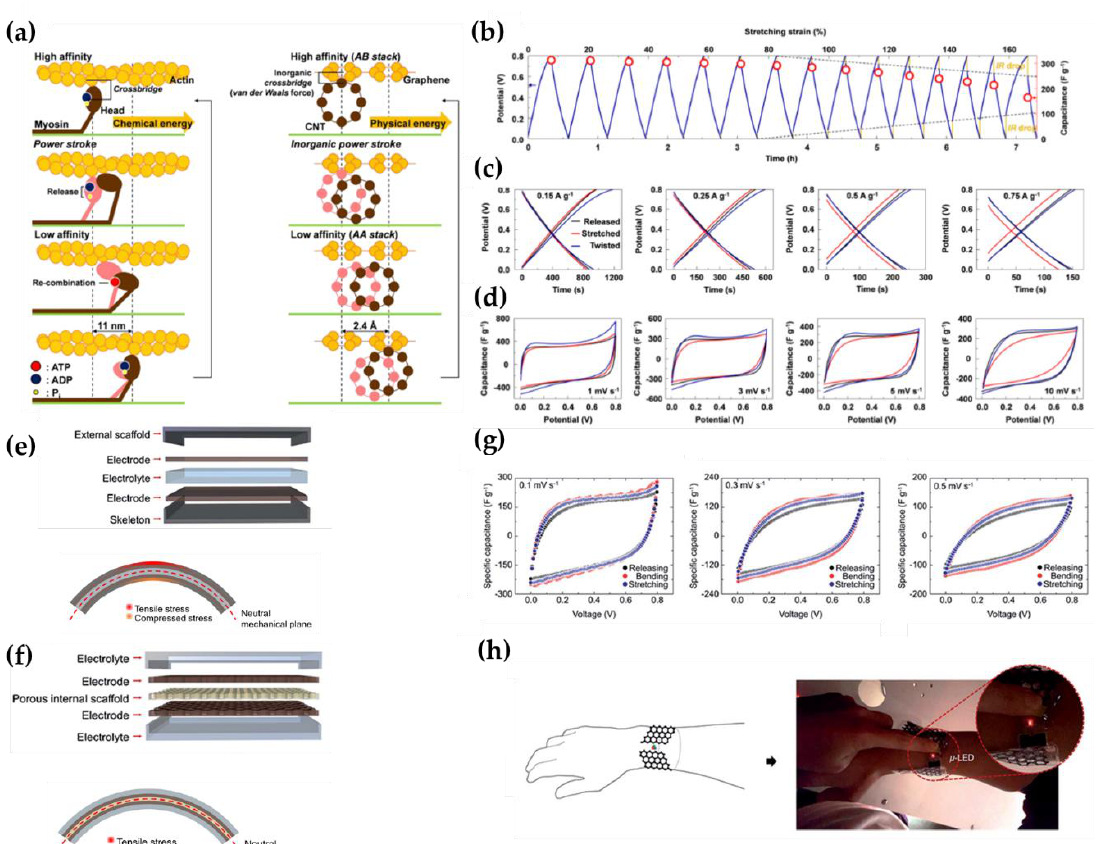
Figure 5. ( a ) Paradigms for the gradual motion of carbon nanotubes (CNTs) along with graphene in an inorganic system and of myosin along actin in a living cell. ( b ) The galvanostatic charging-discharging (GCD) curve for the graphene/CNT layers on polyvinyl alcohol (PVA)/H 3 PO 4 film at a constant current (0.15 A/g) while stretching the structure at a steady rate of 0.4% strain per minute. ( c ) Representative GCDs at several current densities (from 0.15 to 0.75 A/g) without strain and with twisting (360°) and stretching (80%). ( d ) Representative CVs at diverse scan rates (from 1 to 10 mV/s) without strain and with twisting (360°) and stretching (80%) [55]. Copyright (2017), Biomaterials. ( e ) Bending deformation states of energy storages and schematic drawing of an exoskeleton energy storage system. ( f ) Endoskeleton energy storage system. Stretching features of endoskeletons with hexagonally located pore structures and electrochemical properties of the device. ( g ) Representative CVs at 0.1, 0.3 and 0.5 mV/s. ( h ) Employment of the endoskeleton system in a micro-LED device on a wrist [46]. Copyright (2016), Journal of Materials Chemistry.